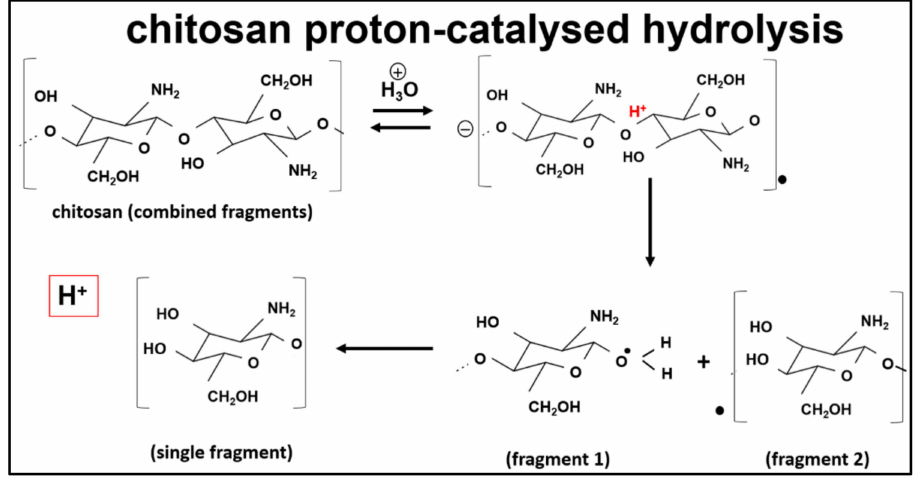
Figure 15. The breakdown of chitosan at pH 3